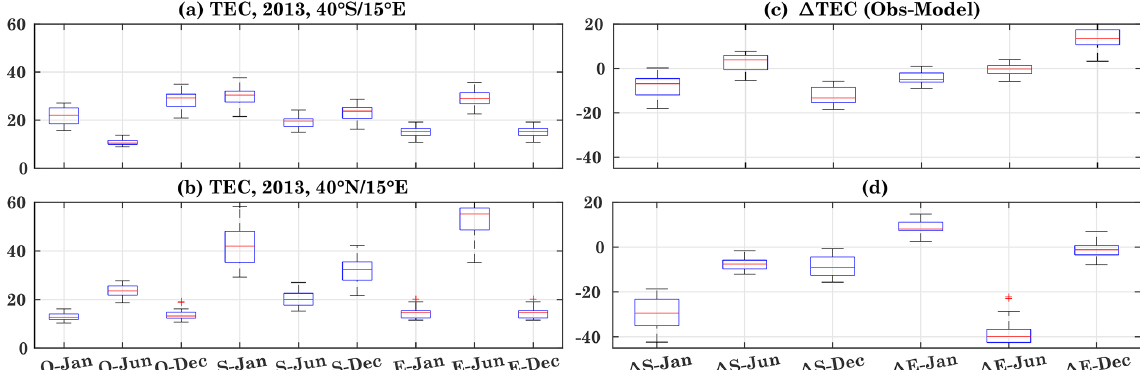
Figure 9. Box plots of observed daily TEC and model-simulated TEC using F10.7A as solar input for 40 ◦ S and 40 ◦ N during January, June, and December for the year